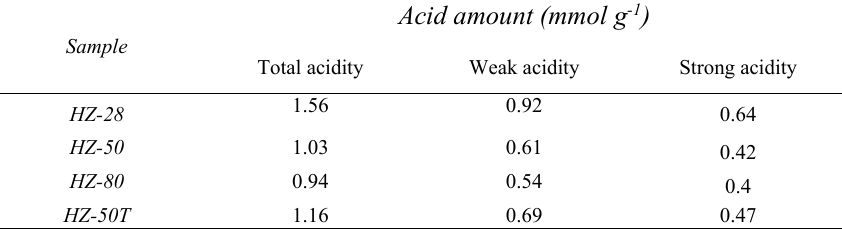
Table .3. NH 3 -TPD data and acid amount for the hierarchical HZSM-5 zeolites with different Si/Al